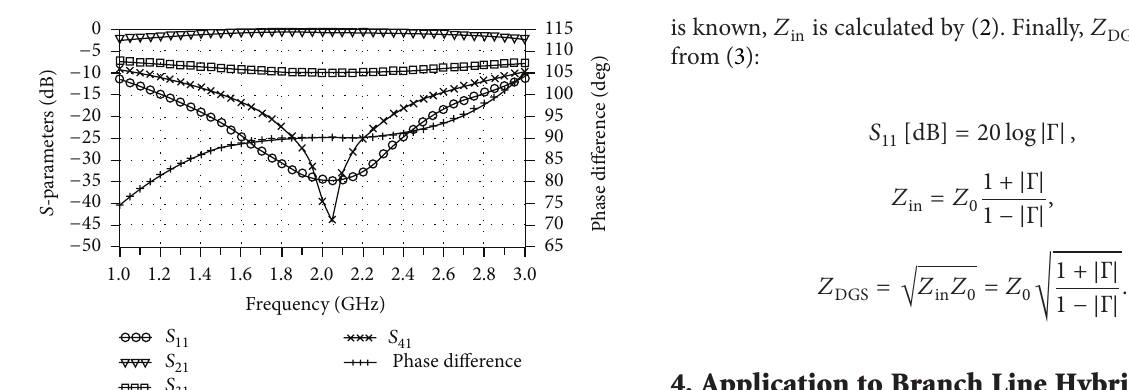
Figure 7: Simulated performances of the 10dB branch line hybrid